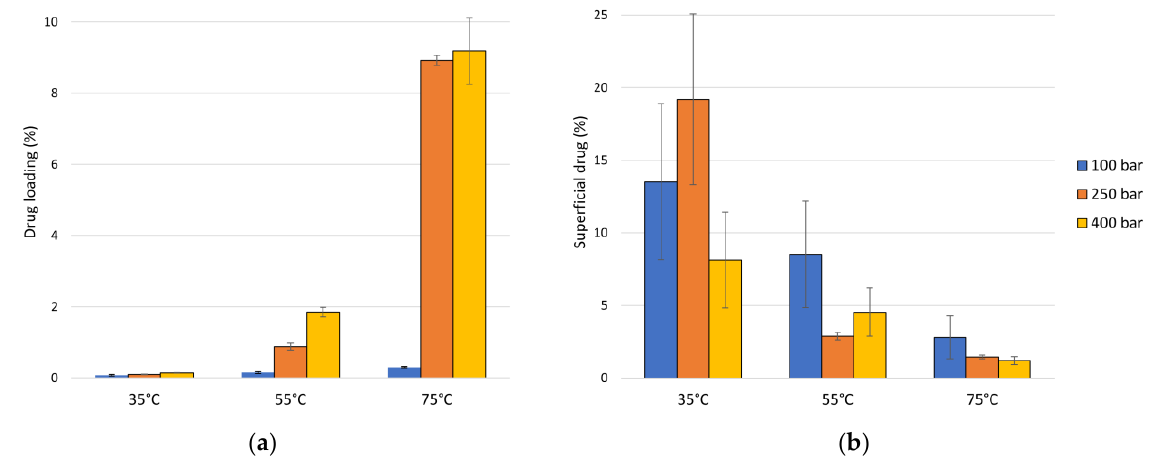
Figure 4. Ketoprofen impregnation loading by SSI into PLA filaments: ( a ) total drug loading: percentage of impregnated ketoprofen respect to the amount of PLA, and ( b ) percentage of superficial drug respect to the total drug loaded.